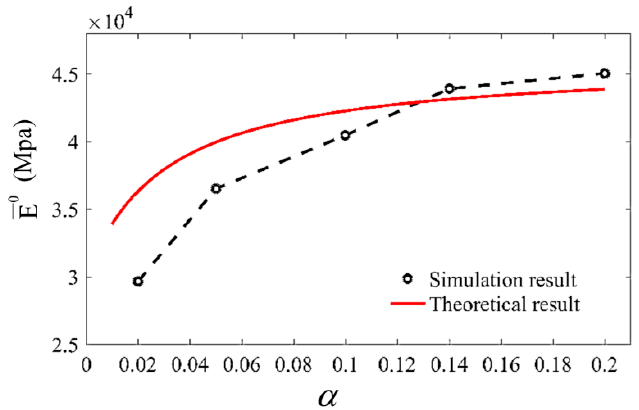
Figure 11. Comparison between FEM simulation and theoretical results of the e ff ective modulus